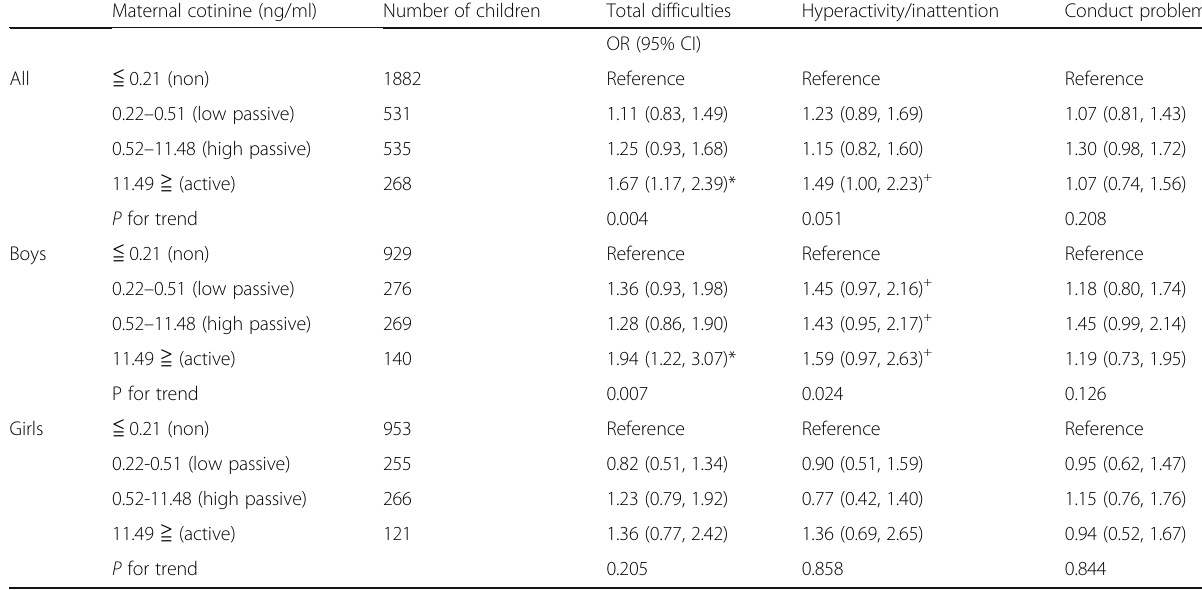
Table 3 Association between maternal cotinine levels at the third trimester and child behavioral problems and ADHD symptoms Maternal cotinine